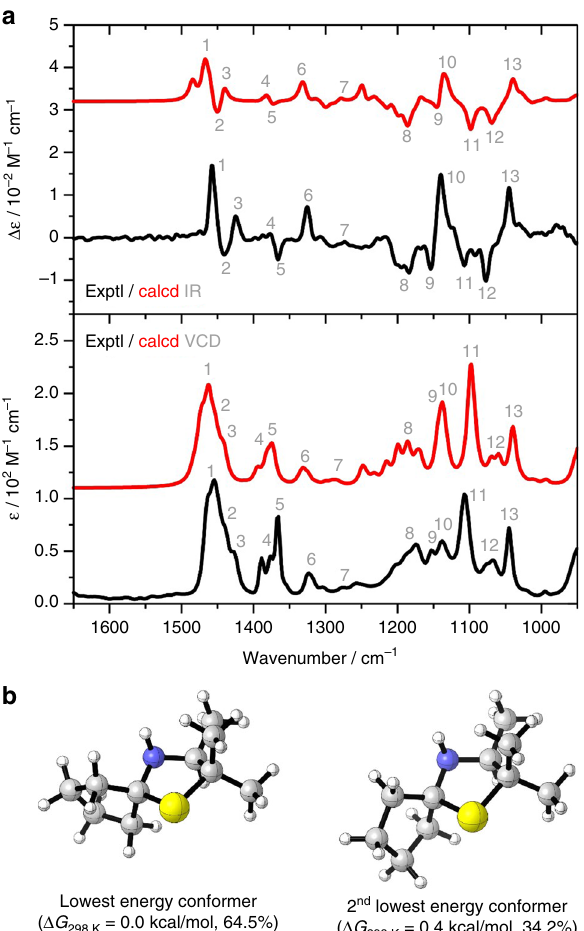
Fig. 4 Determination of absolute con fi guration of 2f . a Comparison of the experimental and calculated IR and VCD spectra of ( S )- 2f (numbers indicate some characteristic band assignments). b Structures of the two main conformers of ( S )- 2f , corresponding relative Gibbs free energies Δ G 298K and the corresponding Boltzmann